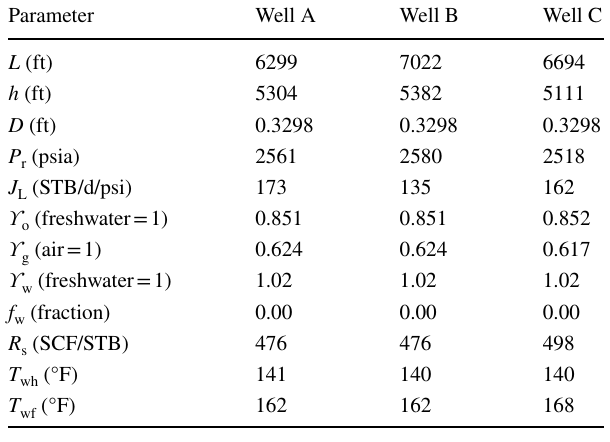
Table 1 Input datasets, for example wells